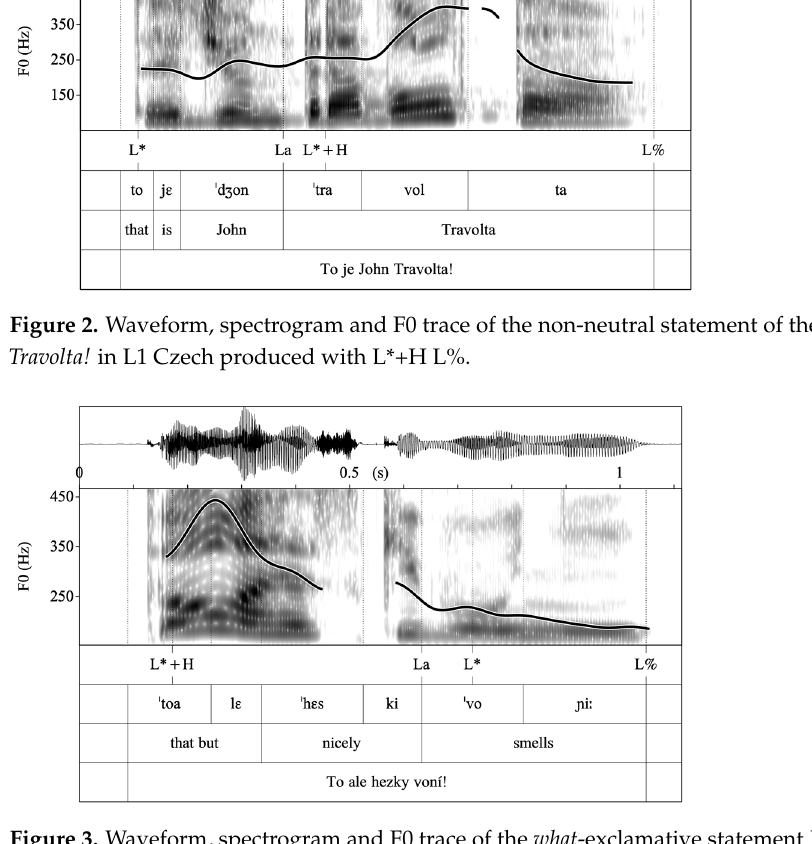
Figure 3. Waveform, spectrogram and F0 trace of the what -exclamative statement What a lovely smell! in L1 Czech produced with L* L%.